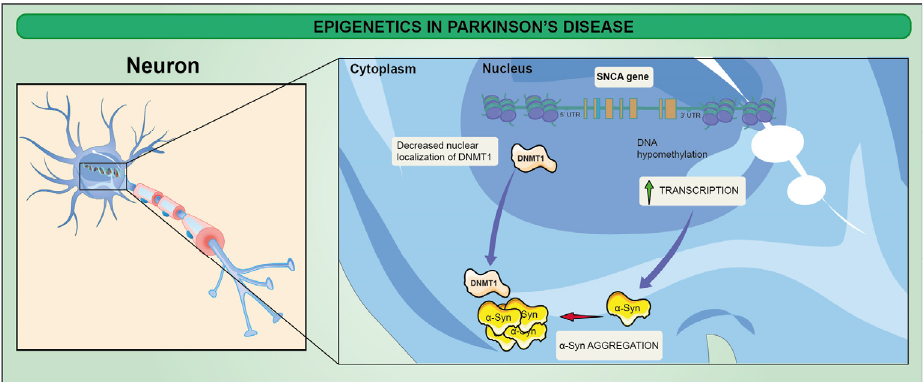
Figure 3. Epigenetics in PD. DNA hypomethylation of SNCA is associated with increase of SNCA expression. DNMT1 (a regulator of DNA methylation) plays an important role in SNCA expression. DNMT1 is mainly located in the nucleus of neurons, and α -Syn aggregation leads to cytoplasmic sequestration of DNMT1, resulting in decreased nuclear localization of DNMT1, which is likely to be involved in the pathogenesis of PD.